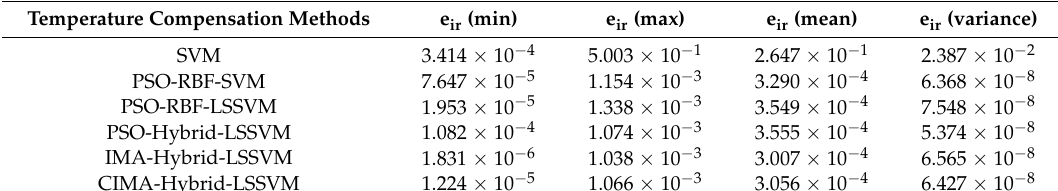
Table 6. Compensation results of testing set by fixed partition.